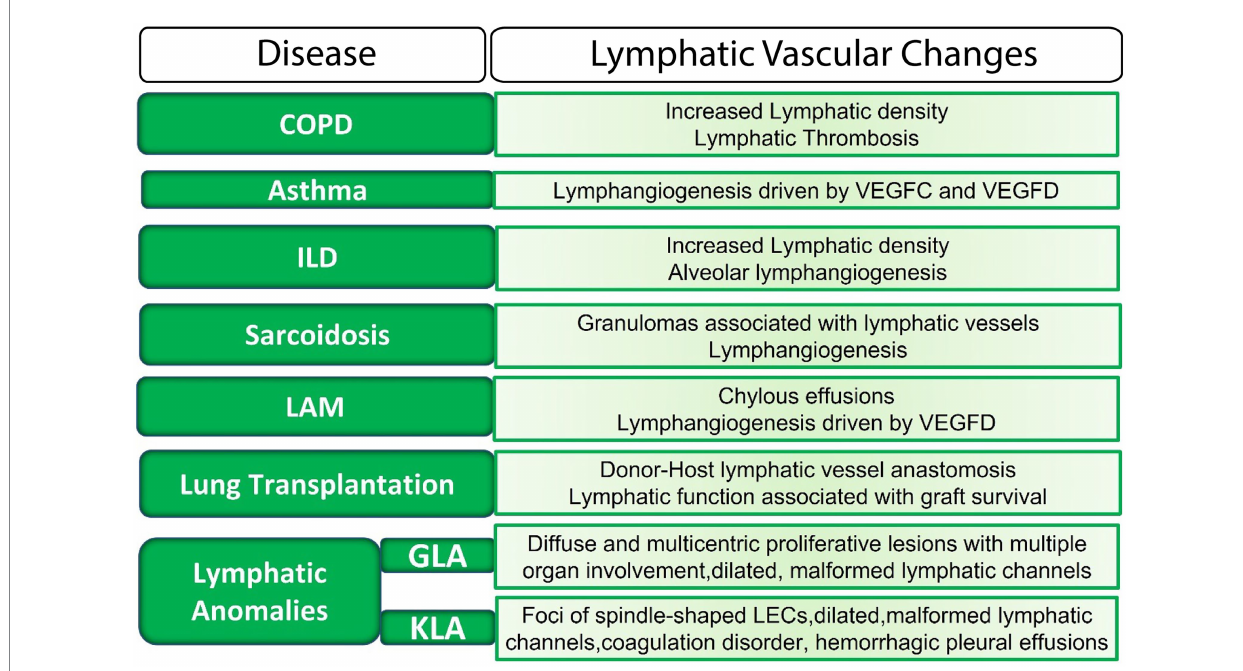
FIGURE 2 The lymphatic vasculature in lung disease. LECs, lymphatic endothelial cells; ILD, interstitial lung disease; LAM, Lymphangioleiomyomatosis; GLA, generalized lymphatic anomaly; KLA, Kaposiform lymphangiomatosis; VEGF, vascular endothelial growth